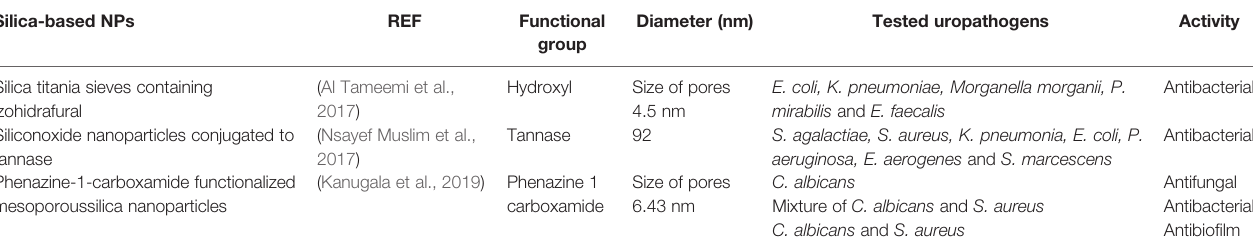
TABLE 9 | Physicochemical characteristics of silica-based